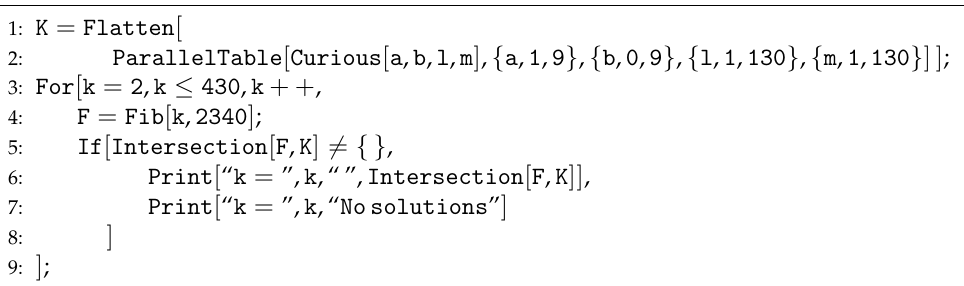
Algorithm A2 The final search